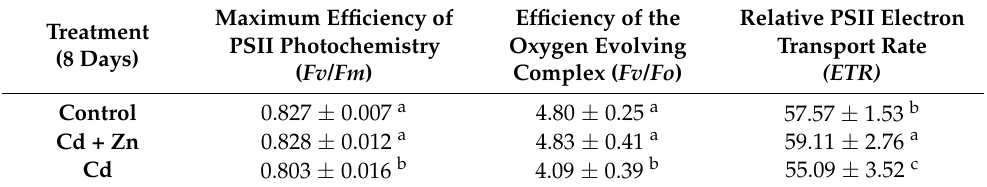
Relative PSII Electron Transport Rate